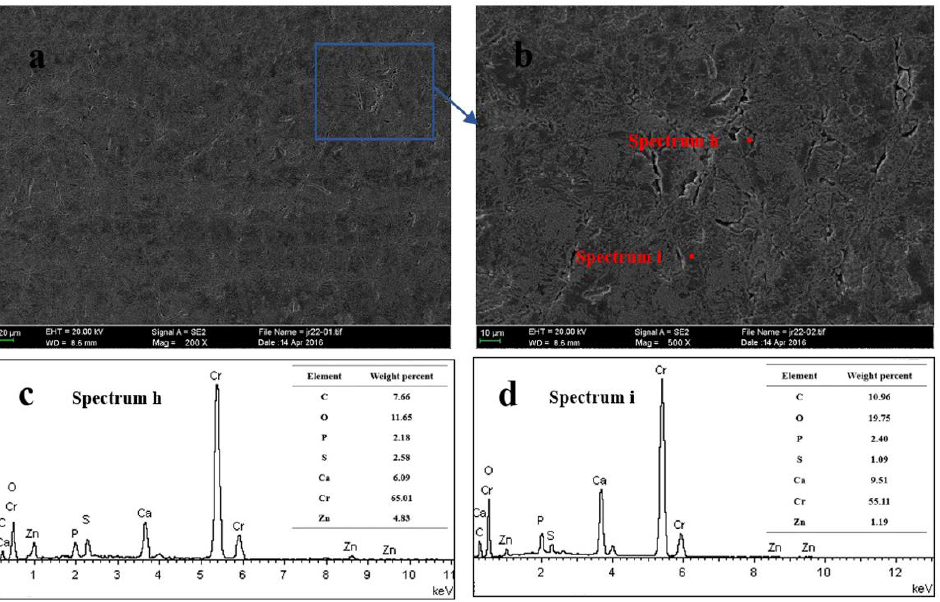
Figure 12. Surface topography ( a ), enlarged area topography ( b ) and position h ( c ) and position i ( d ) element contents of CuSn-Cr coated piston ring.